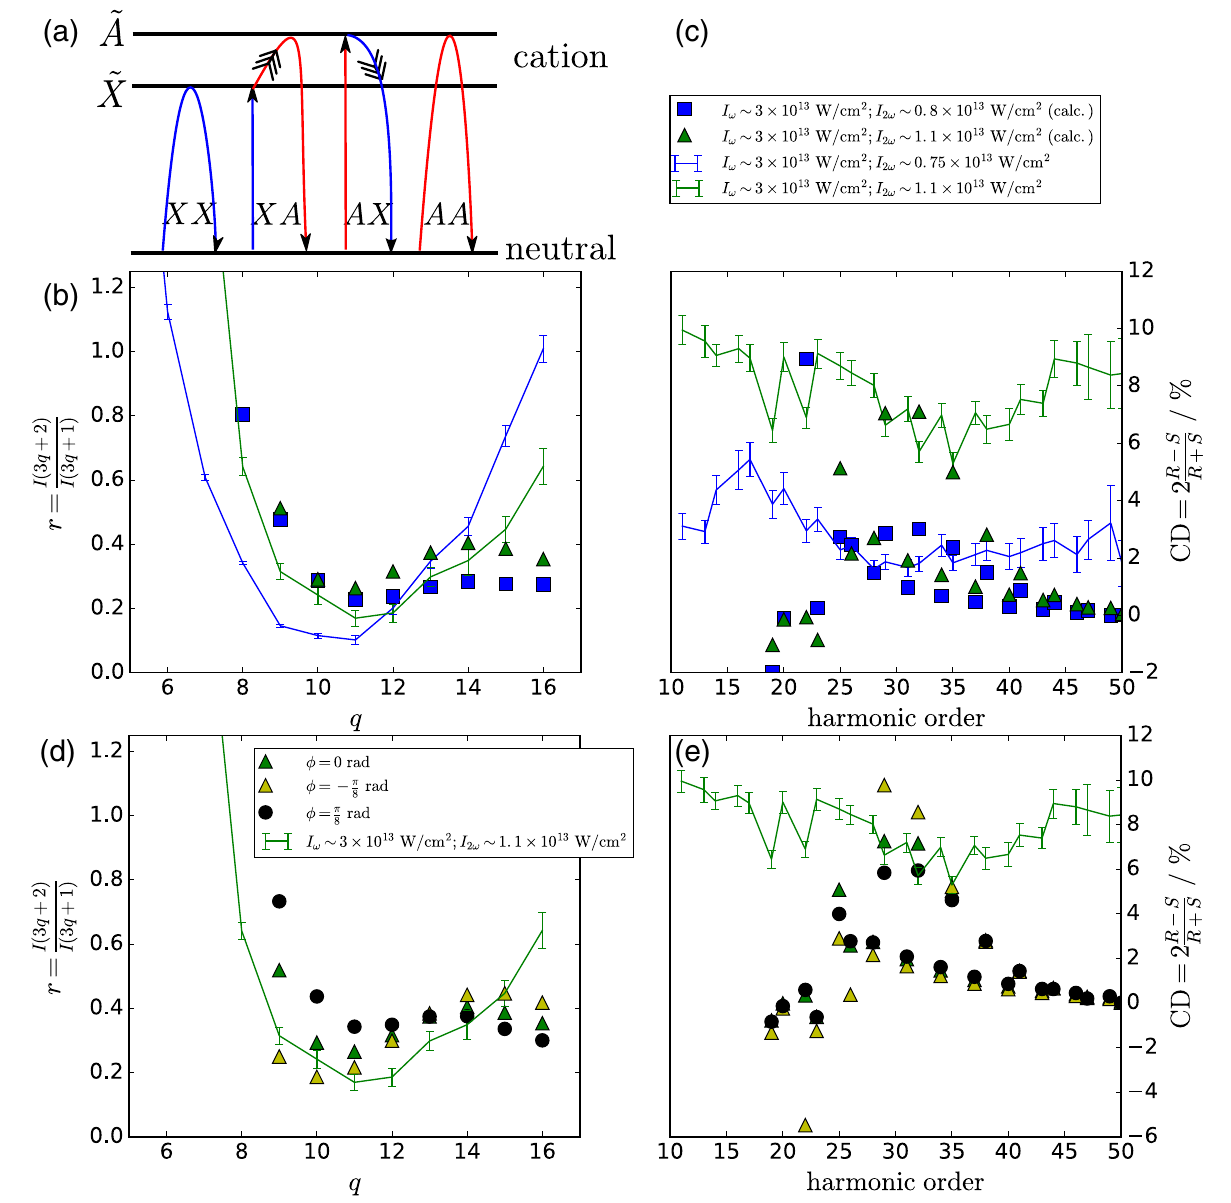
FIG. 5. Comparison of predicted and observed CD in BHHS. (a) Schematic illustration of the four ionization-recombination paths considered in the model. (b) Comparison (experiment versus theory) of the intensity ratios between two neighboring allowed harmonics at two different experimental conditions (cf. legends). (c) Energy dependence of the calculated CD: theory (markers) versus experiment (solid lines). (d) and (e) Calculated result for the intensity ratios (d) and the CD degree (e) using three different values of the initial phase ϕ between the two cationic